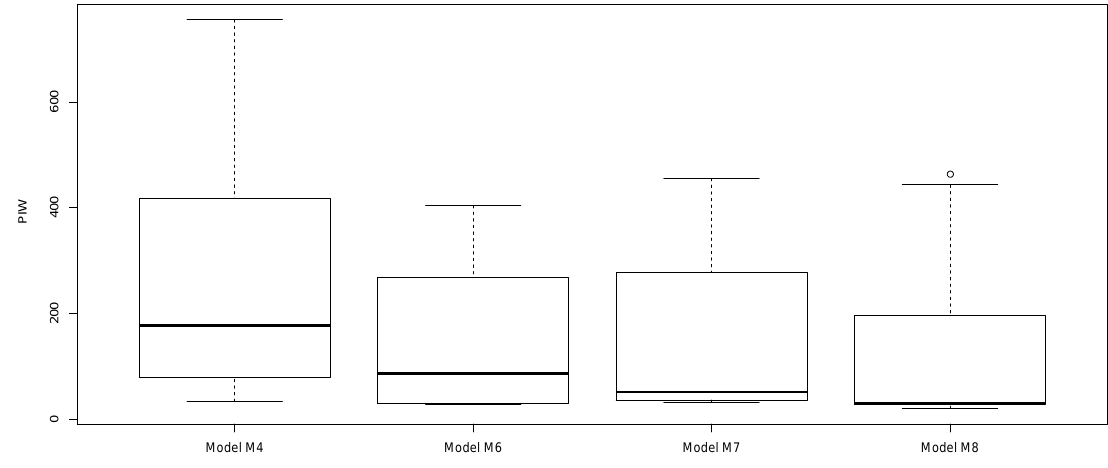
Figure 5. Box plots of the rediction interval widths (PIWs) for models M4, M6, M7 and M8. PIW of model M8 appear to be the narrowest compared to the PIWs of the other